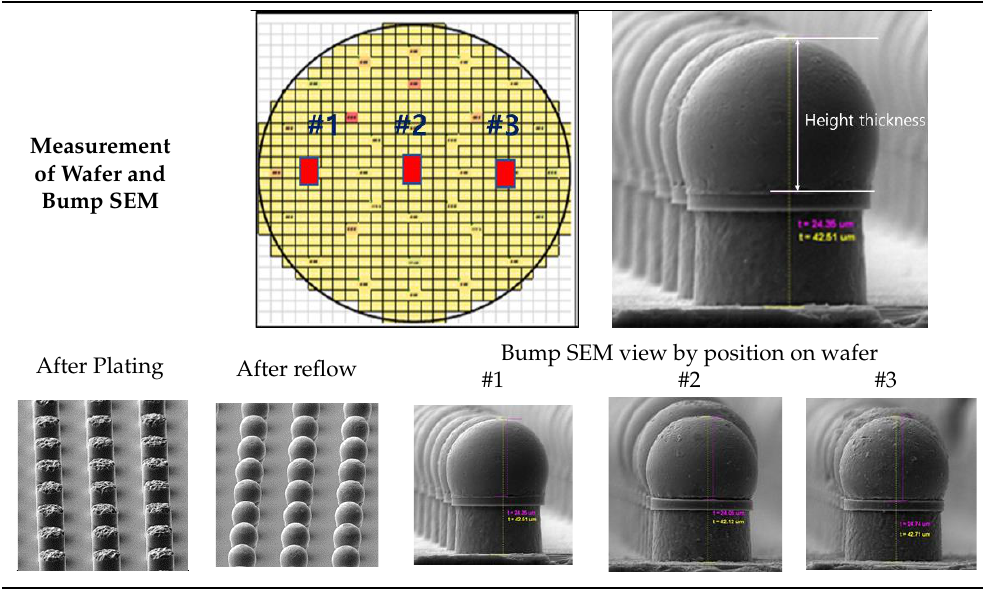
Figure 8. Pure Sn bumps manufactured on 4-inch wafers. ( a ) Reflow profile, ( b ) Pure Sn bump before reflow, and ( c ) Pure Sn bump after reflow.